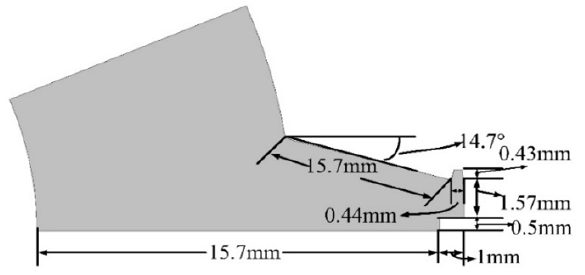
Figure 26. Hybrid (arc, flange and notch) of the rotor